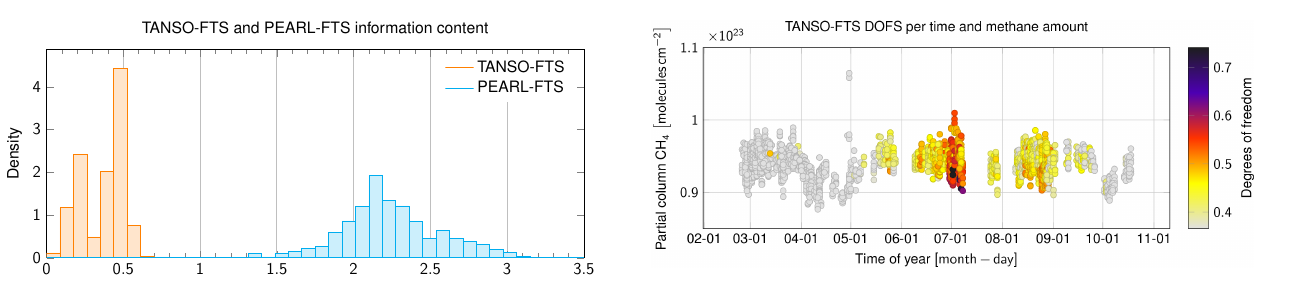
Figure 4. TANSO-FTS DOFS per profile as a function of season and methane partial column. The calculation of partial columns is described in Sect. 2.7, and the range of altitudes considered is described in Table 2. The vertical axis shows TANSO-FTS par- tial columns for 5.3–9.7km, but DOFS relate to the entire profile. The figure includes all 2804 TANSO-FTS profiles collocated with PEARL-FTS.